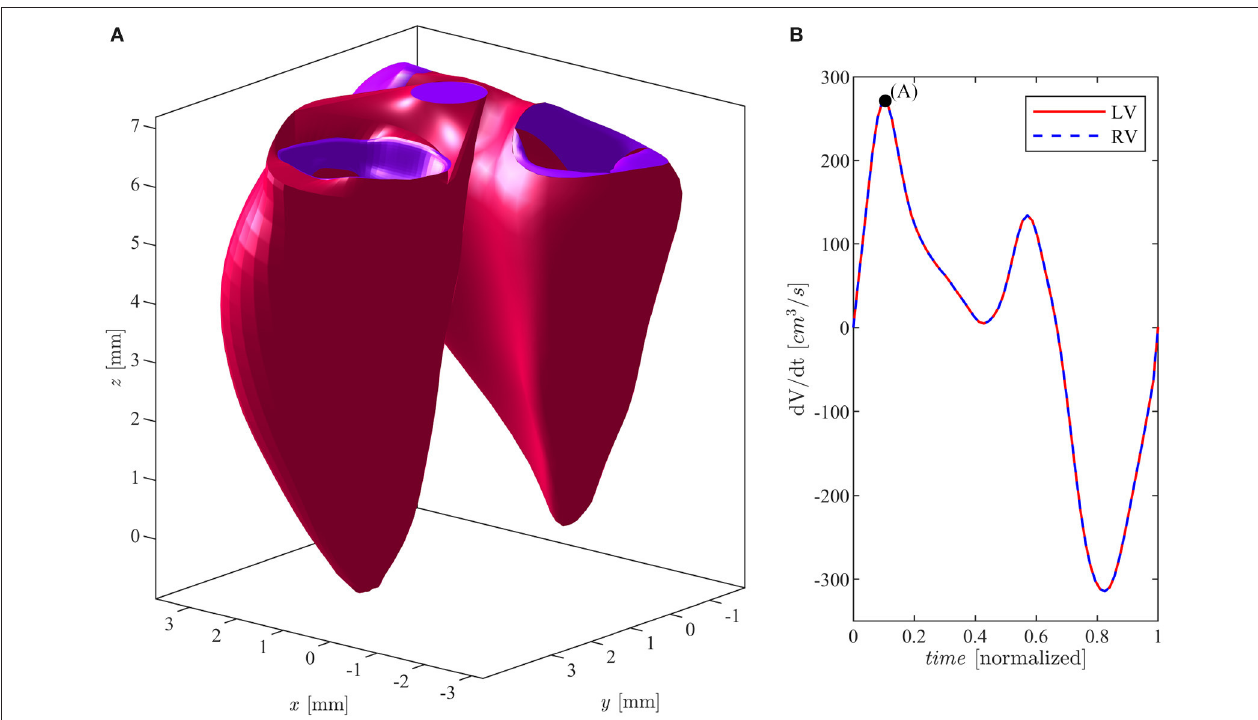
FIGURE 1 | (A) Left and right ventricles in E-wave peak position. (B) Flow rate curve during cardiac cycle for both